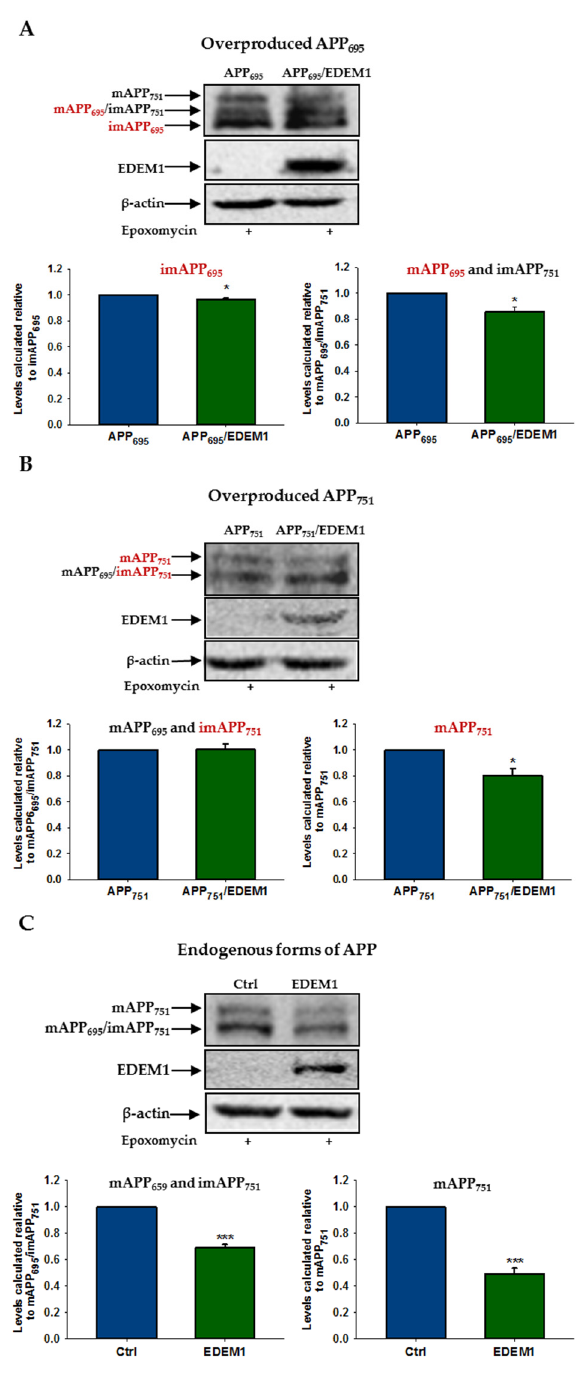
Figure 5. The effect of EDEM1-dependent intracellular reduction on the level of APP isoforms is significantly attenuated after proteasome inhibition. Western blotting of APP, EDEM1 and actin in lysates of cells transfected with ( A ) APP 695 , ( B ) APP 751 , or ( C ) control cDNA with or without EDEM1 cotransfection (as indicated). Cells were treated with 10 µM lactacystin or 1 µM epoxomicin for 5 h before cell lysis. Overexpressed, dominant forms present in ( A ) and ( B ) are indicated in red. Representative experiments are shown for cells treated with epoxomicin. Similar results were obtained for cells treated with lactacystin. The levels of APP isoforms were quantified and are shown in the graphs. Values obtained for lysates of cells without EDEM1 overexpression are indicated as 1. Values representing EDEM1-transfected cells are plotted relative to 1. The values are expressed as mean ± SD, n ≥ 3, * p ˂ 0.05, *** p ˂ 0.001, Student’s t test.